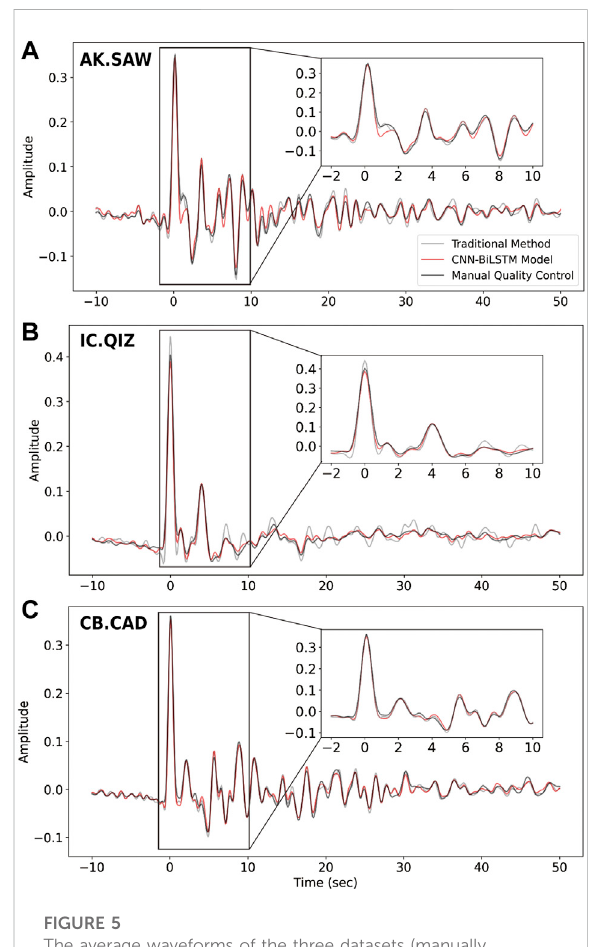
FIGURE 5 The average waveforms of the three datasets (manually quality controlled dataset with magnitudes larger than 5.5, automatically quality controlled dataset by the CNN-BiLSTM model with magnitudes between 5.0 and 5.5 and automatically quality controlled dataset by the traditional method inHiPerSeiswithmagnitudes between5.0and5.5)recordedby (A) AK. SAW station, (B) IC. QIZ station, and (C) CB. CAD